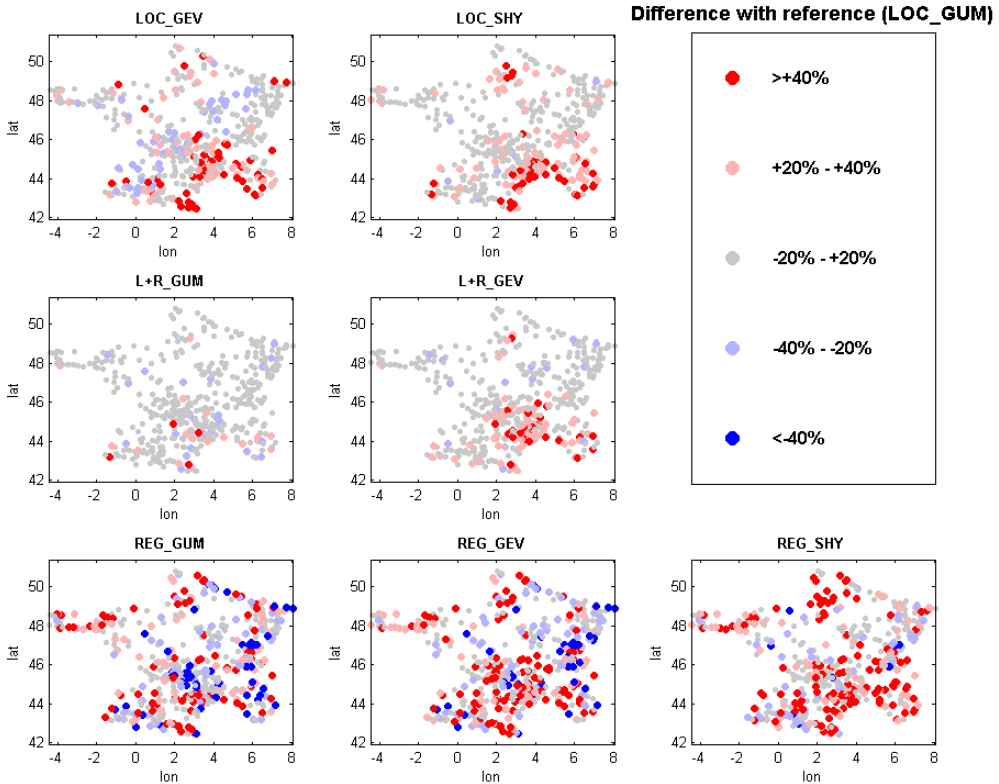
Fig. 3. Relative differences between 0.99 quantiles.